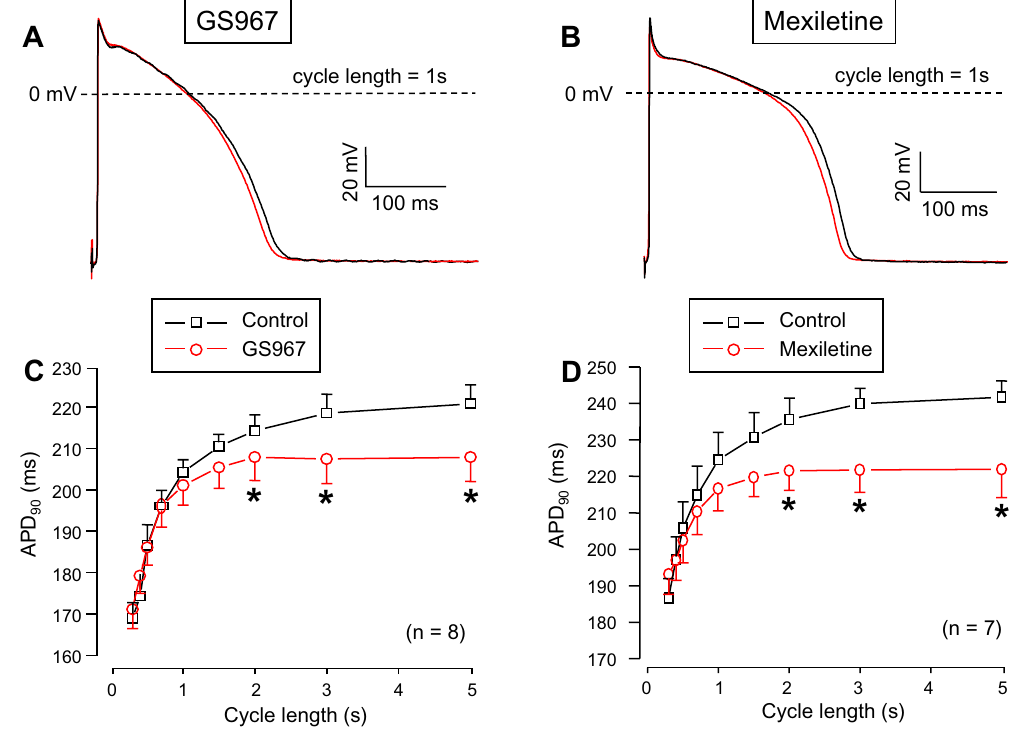
Figure 5. Cycle length-dependent e ffects of GS967 ( A , C ) and mexiletine ( B , D ) on AP duration measured at 90% of repolarization (APD 90 ) in canine right ventricular trabeculae under steady-state conditions. During the experiments the cycle length was gradually changed between 0.3 and 5 s. ( A , B ) Representative superimposed analogue action potential pairs obtained at the constant pacing cycle length of 1 s before and after superfusion with 1 µM GS967 or 40 µM mexiletine. ( C , D ) Average rate-dependent APD values. Symbols and bars are mean ± SEM, numbers in parentheses indicate the number of preparations studied, asterisks denote significant differences between data of the pre-drug control and the GS967- or mexiletine-treated